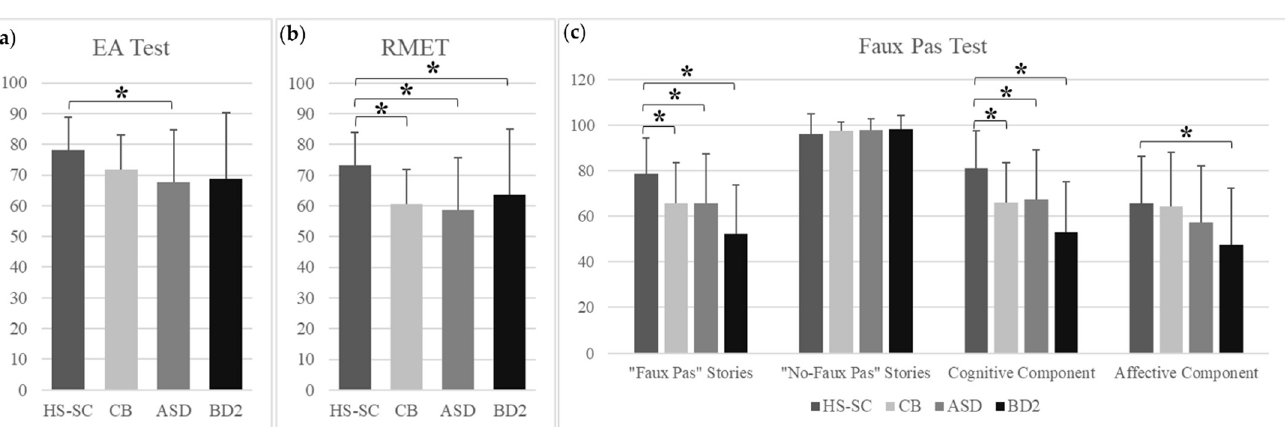
Figure 1. Results of the Social Cognition battery. ( a ) EA Test results. Scores are reported as the percentage of the overall number of accurate answers (max = 58). ( b ) RMET results. Scores are reported as the percentage of the overall number of accurate answers (max = 36). ( c ) Faux Pas Test results. Scores are reported as the percentage of the overall number of accurate answers given to all the questions of the faux pas stories (max = 60) and no-faux pas stories (max = 20), to the ques- tions evaluating the Cognitive Component (max = 50) and to those evaluating the Affective com- ponent (max = 10). For each group, mean and standard deviation of the percentage of accuracy are reported, with 0% representing completely incorrect responses and 100% representing completely accurate responses; * p < 0.05. Abbreviations: HS-SC, healthy subjects; CB, degenerative cerebellar damage; ASD, autism spectrum disorders; BD2, bipolar disorders type 2. Table 2. Means and standard deviation of scores obtained in each SC test by each group.